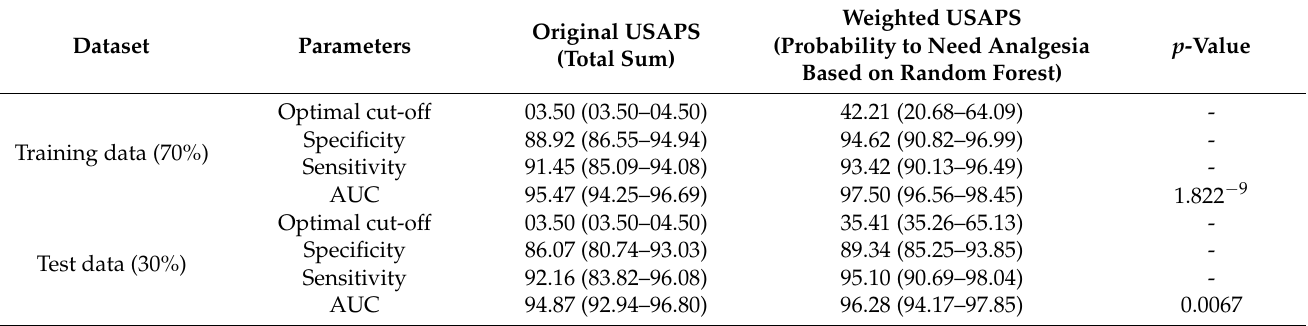
Table 3. Optimal cut-off, specificity, sensitivity, and area under the curve from the receiver operating characteristic curve of the original USAPS and weighted USAPS from random forest algorithm (no event = no indication of analgesia; event = indication of analgesia).